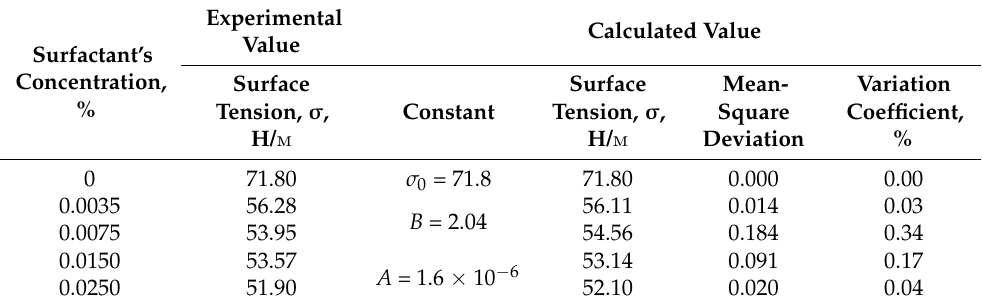
Table 4. Evaluation of applicability of Shishkovsky’s empirical equation for description of the impact of the ViscoCrete-2100 concentration on the surface tension of aqueous solutions.